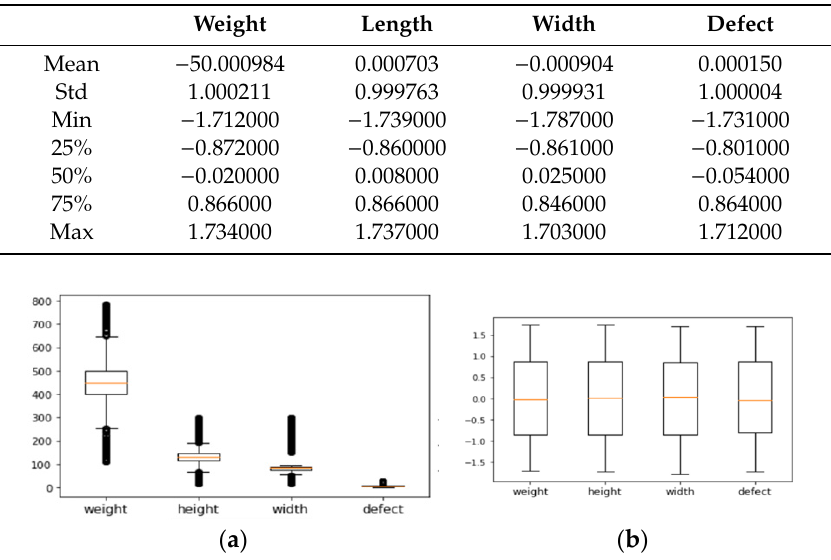
Figure 14. The implemented process of data normalization and elimination of outliers. ( a ) A graphical rendition of the original data based on the box plot; ( b ) a graphical rendition of the data using DNEO based on the box plot.